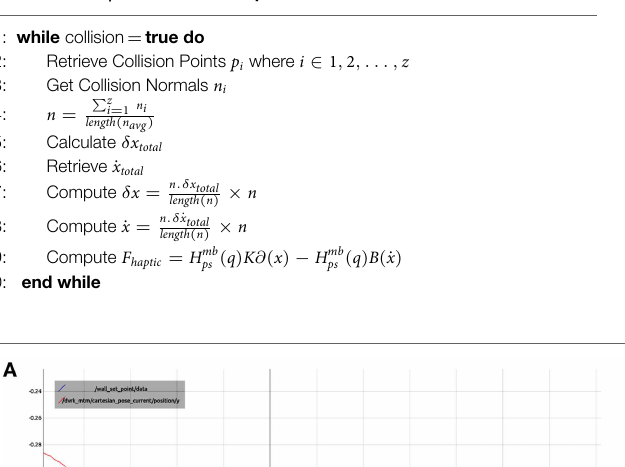
ALGORITHM 1 | Generation of haptic feedback .